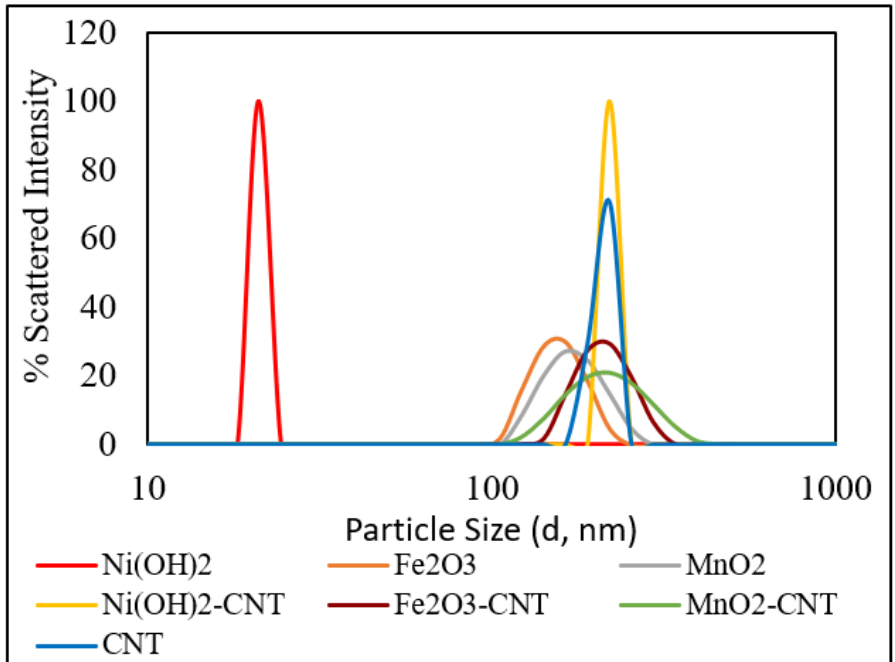
Figure 3. Particle size distribution of the MOs, CNTs and MO-CNT hybrids.